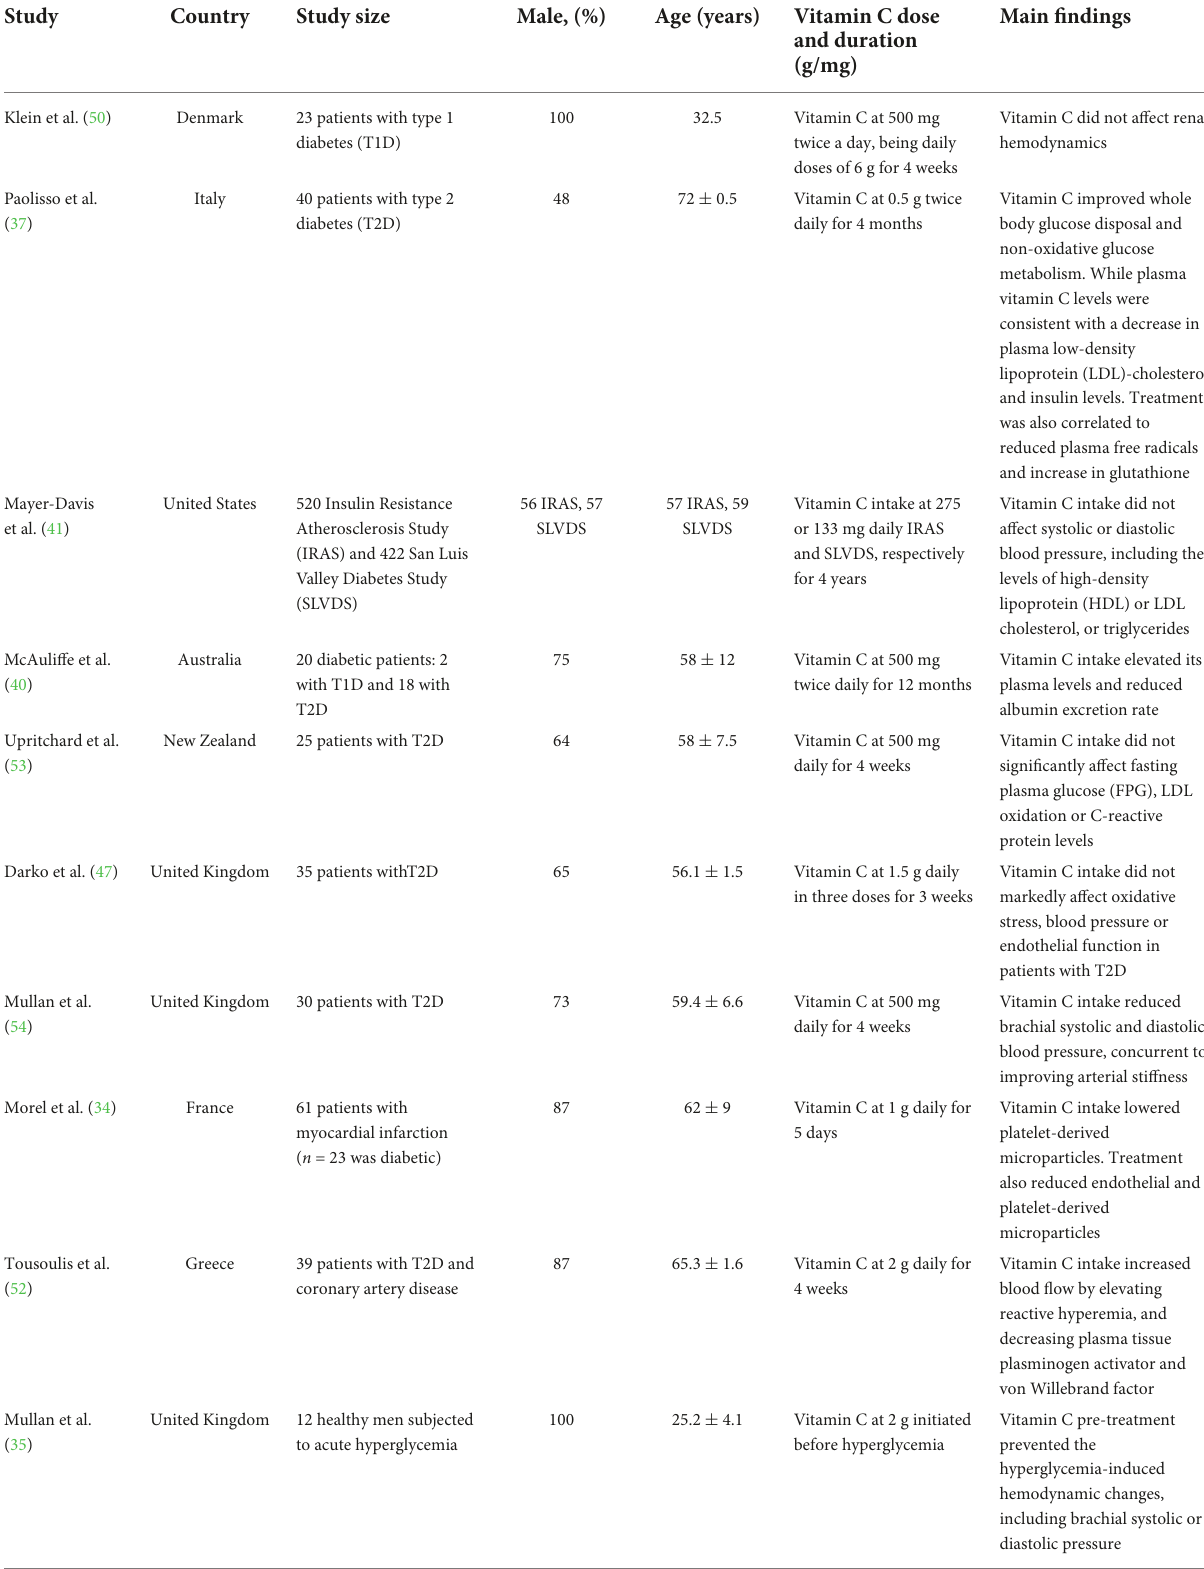
TABLE 1 An overview of studies reporting on the impact of vitamin C intake on cardiovascular disease (CVD)-related